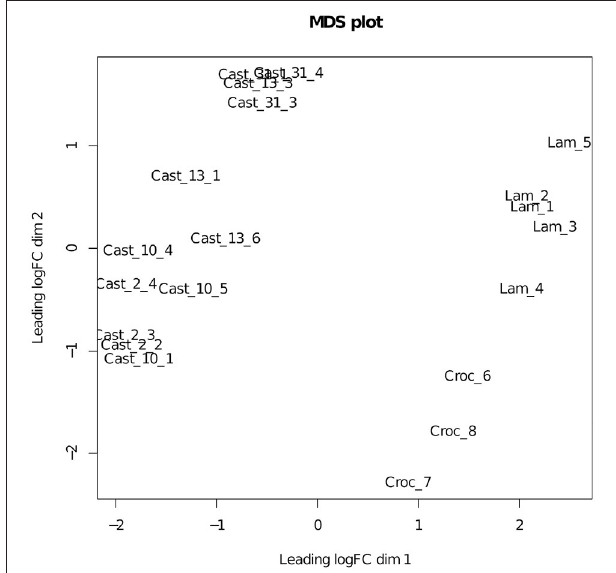
FIGURE 2 | MDS plot of the additive expression matrix for T. castellanus and its diploid progenitors. Lam represents T. lamottei , Croc represents T. crocifolius , and Cast represents T. castellanus